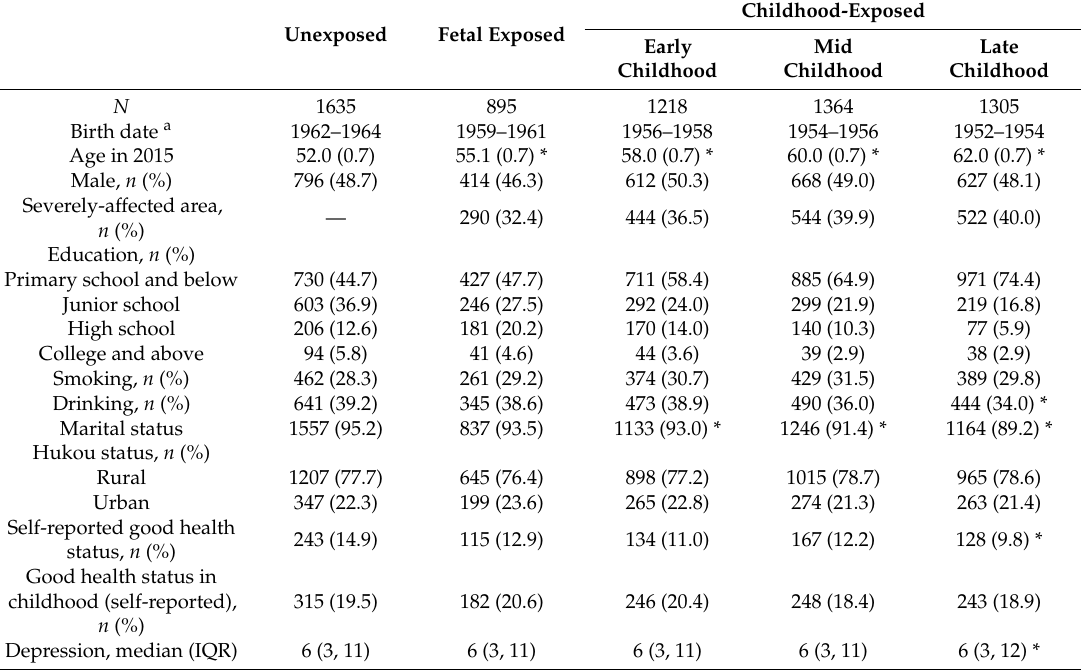
Table 1. General characteristics of the respondents in the five Chinese famine-exposed